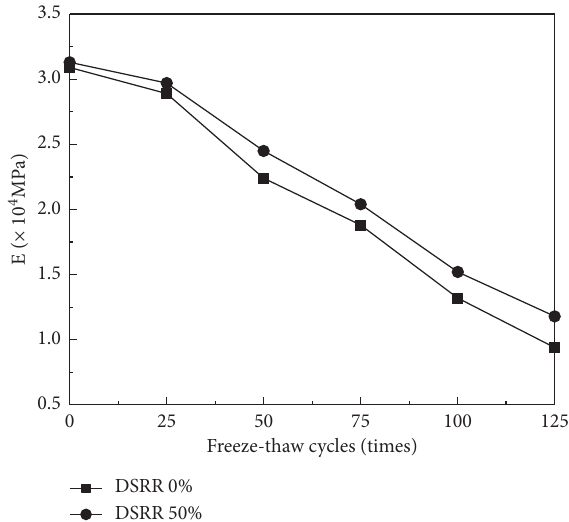
Figure 11: Relation between elastic modulus and freeze-thaw